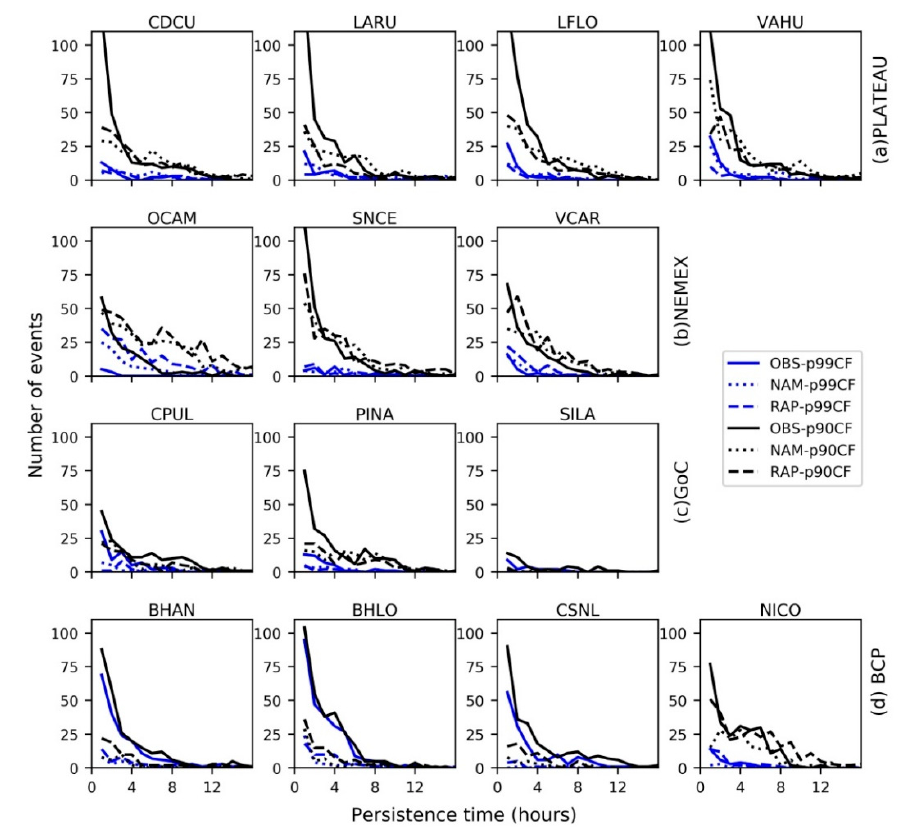
Figure 13. Extreme events of high generation observed (continuous line), NAM (dotted line) and RAP (dashed line) for 2013. Moderate extreme events correspond to the 90th percentile (black line) of instantaneous capacity factor (CF). Regions are ( a ) Plateau, ( b ) NEMEX, ( c ) GoC, ( d ) BCP.